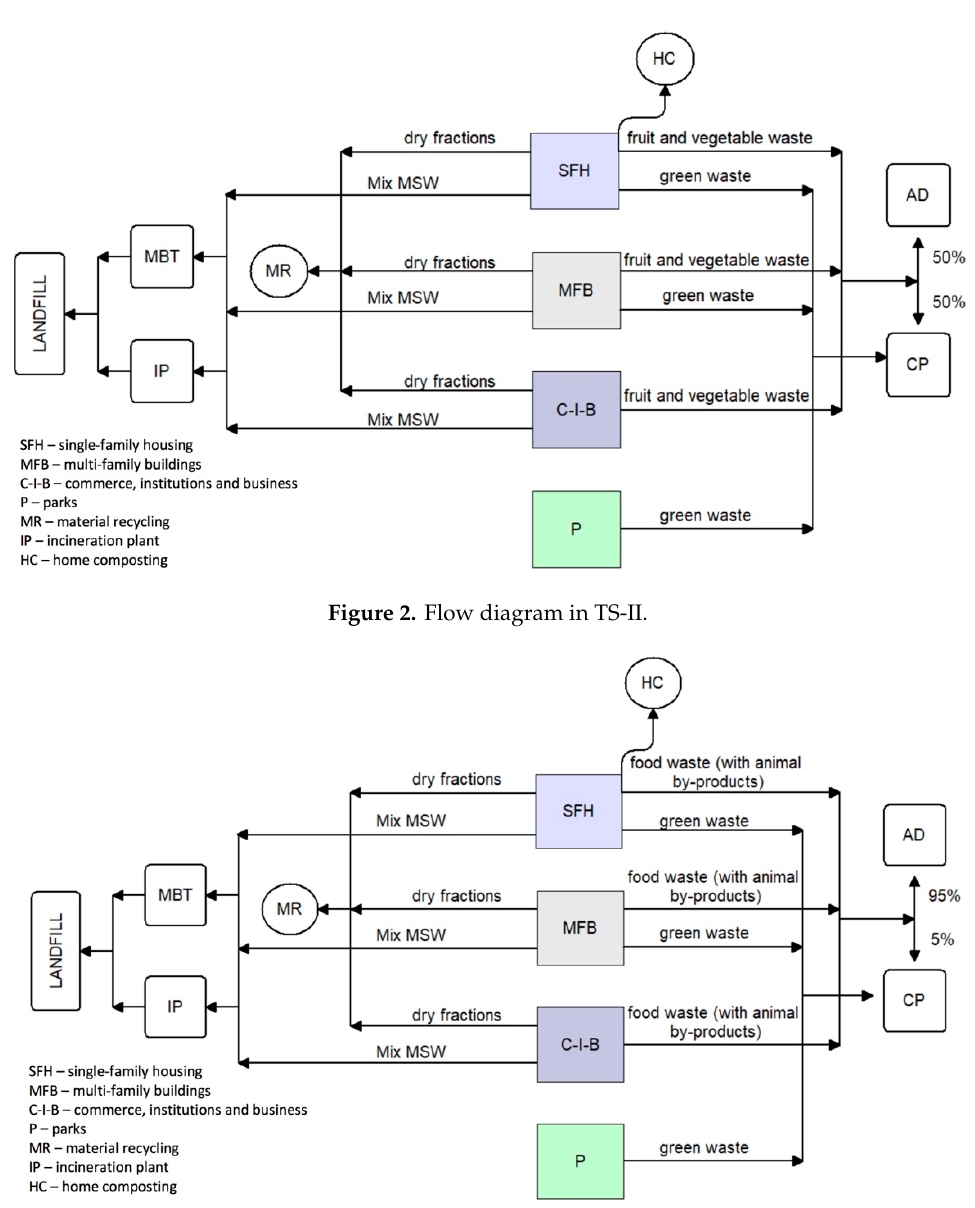
Figure 3. Flow diagram in TS ‐ III.